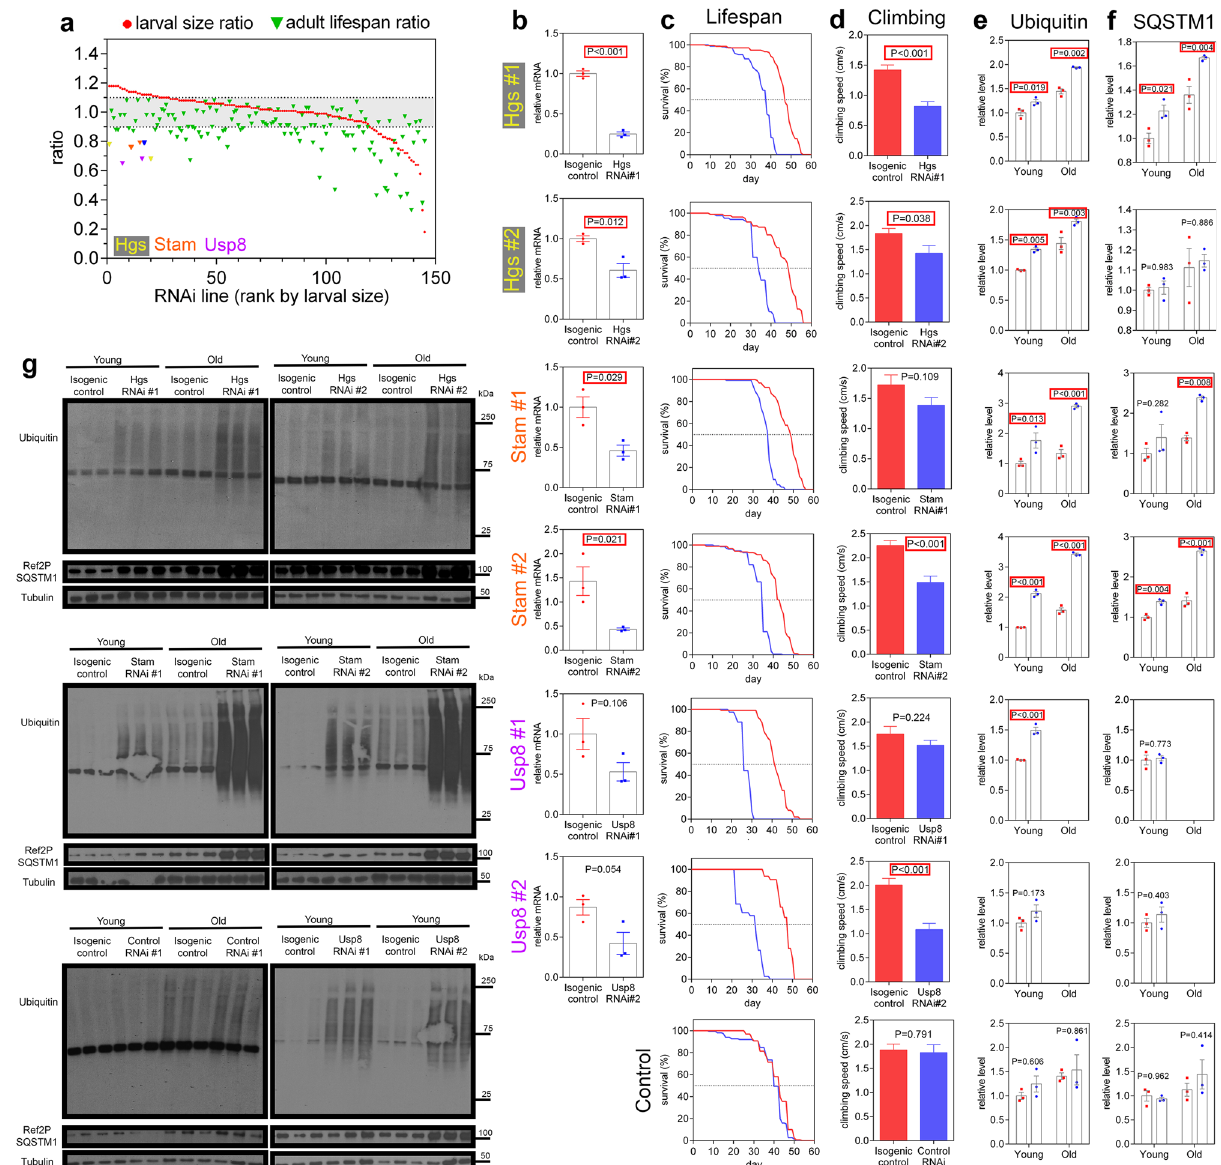
Fig. 7 Ubiquitin ligases and related genes that negatively regulate myo fi ber size are positive regulators of muscle protein quality control, muscle function, and lifespan. a RNAi that regulates developmental myo fi ber growth with Mef2-GAL4 (red dots) are examined for their capacity to regulate the median lifespan when expressed in adult muscle with MHCF3-GAL4 (green triangles). In addition to UBR4, HGS, STAM, and USP8, many RNAi interventions that increased myo fi ber size during development reduced lifespan when modulated solely in adulthood (ratio of changes in the median lifespan compared to the isogenic control corresponding to each line). Median lifespan was derived from groups of >50 fl ies per RNAi line. b As expected, target genes are knocked down in the muscle of fl ies with muscle-speci fi c RNAi driven by MHCF3-GAL4 , compared to isogenic controls carrying the same transgenic RNAi but lacking MHCF3-GAL4 . c Survival curves for HGS, STAM, and USP8 RNAi, each compared to its matched isogenic control. d Muscle function at 10 days of age is decreased as indicated by the reduced climbing speed compared to isogenic controls. For c , d information on n is provided in the Source Data fi le. e – g Muscle-speci fi c knockdown of HGS, STAM, and USP8 increase the detergent-insoluble levels of ubiquitin and SQSTM1/Ref(2)P in thoracic skeletal muscles from young (10 days) and old fl ies (35 days) compared to isogenic controls whereas control RNAi had no effect compared to its isogenic control (note that fl ies with USP8 knockdown were short-lived and samples could not be obtained at old ages for these analyses). In b , e , f n = 3 biological replicates each consisting of 10 fl y thoraces. Data are presented as mean ± SEM. In b , d two-tailed Student ’ s t -test was used. In e , f statistics were calculated by using two-way ANOVA with Tukey ’ s post hoc test with adjustment for multiple